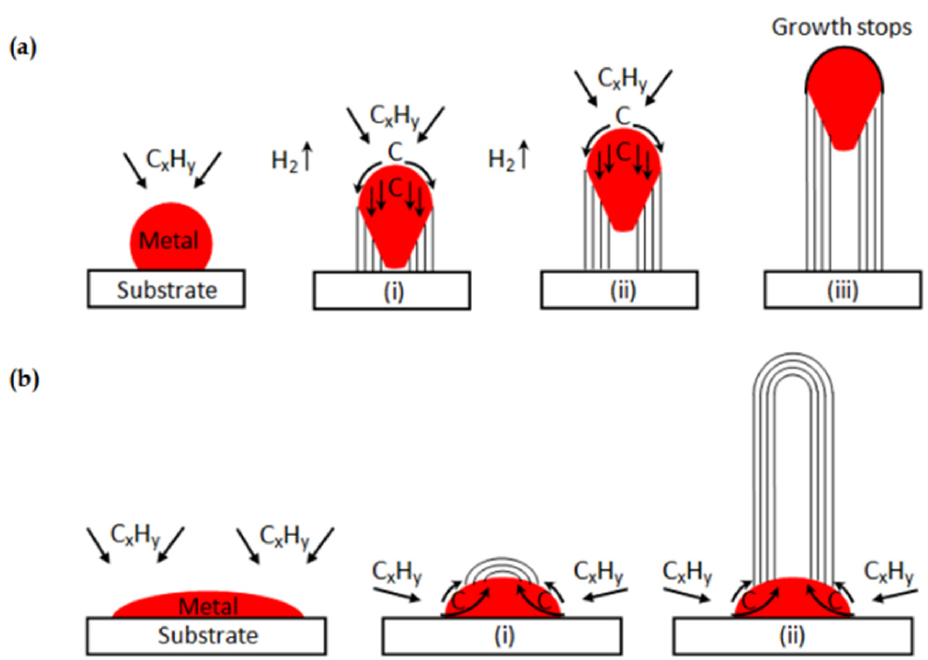
Figure 12. ( a ) Carbon filaments followed the “tip growth” mechanism, in which catalyst is enclosed at the tip of the carbon filament; ( b ) Carbon filaments followed the “base growth” mechanism, in which catalyst remains at the bottom of the growing carbon [53].